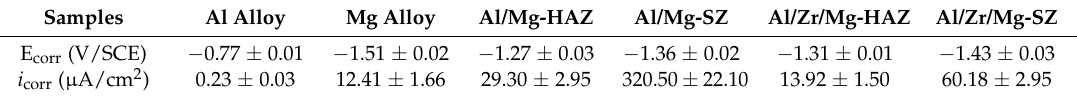
Figure 7. Potentiodynamic polarization curves for the representative regions of the Al/Mg and Al/Zr/Mg joints in the 3.5% NaCl solution. Table 4. Electrochemical parameters fitted from the potentiodynamic polarization curves.